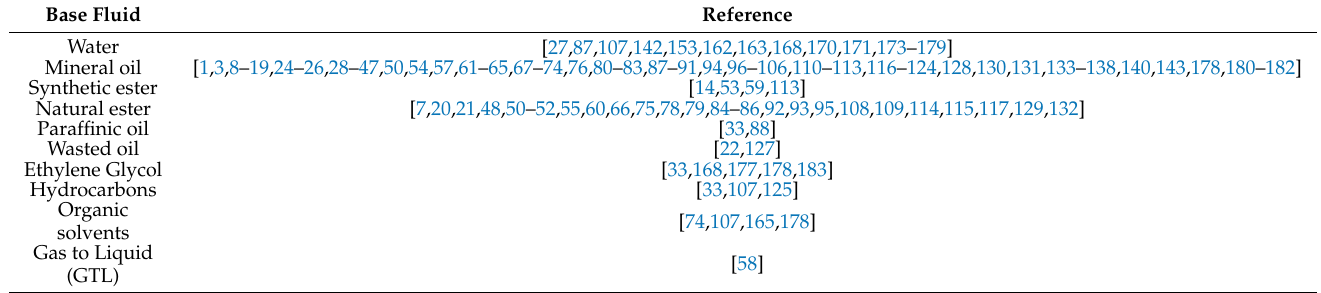
Table 9. Classification of references as a function of the base fluid that was used.